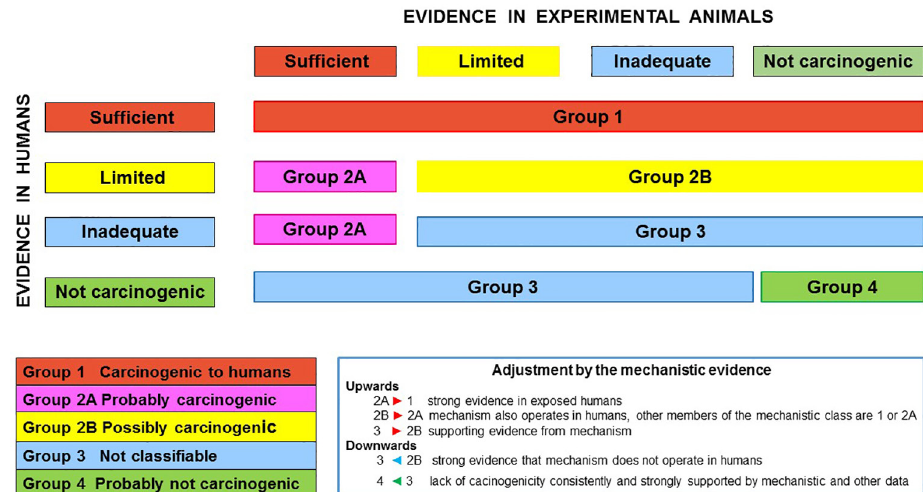
FIGURE 2 - IARC’s cancer hazard-based classifcation scheme. The classification into a cancer-hazard category (Group 1, 2A, 2B, 3 or 4) relies fundamentally on a separate assessment of the evidence in humans and in animals. The IARC overall cancer-hazard category may be adjusted upwards or downwards depending on the strength of the evidence on the underlying mechanisms of carcinogenesis and whether or not they are likely to operate in